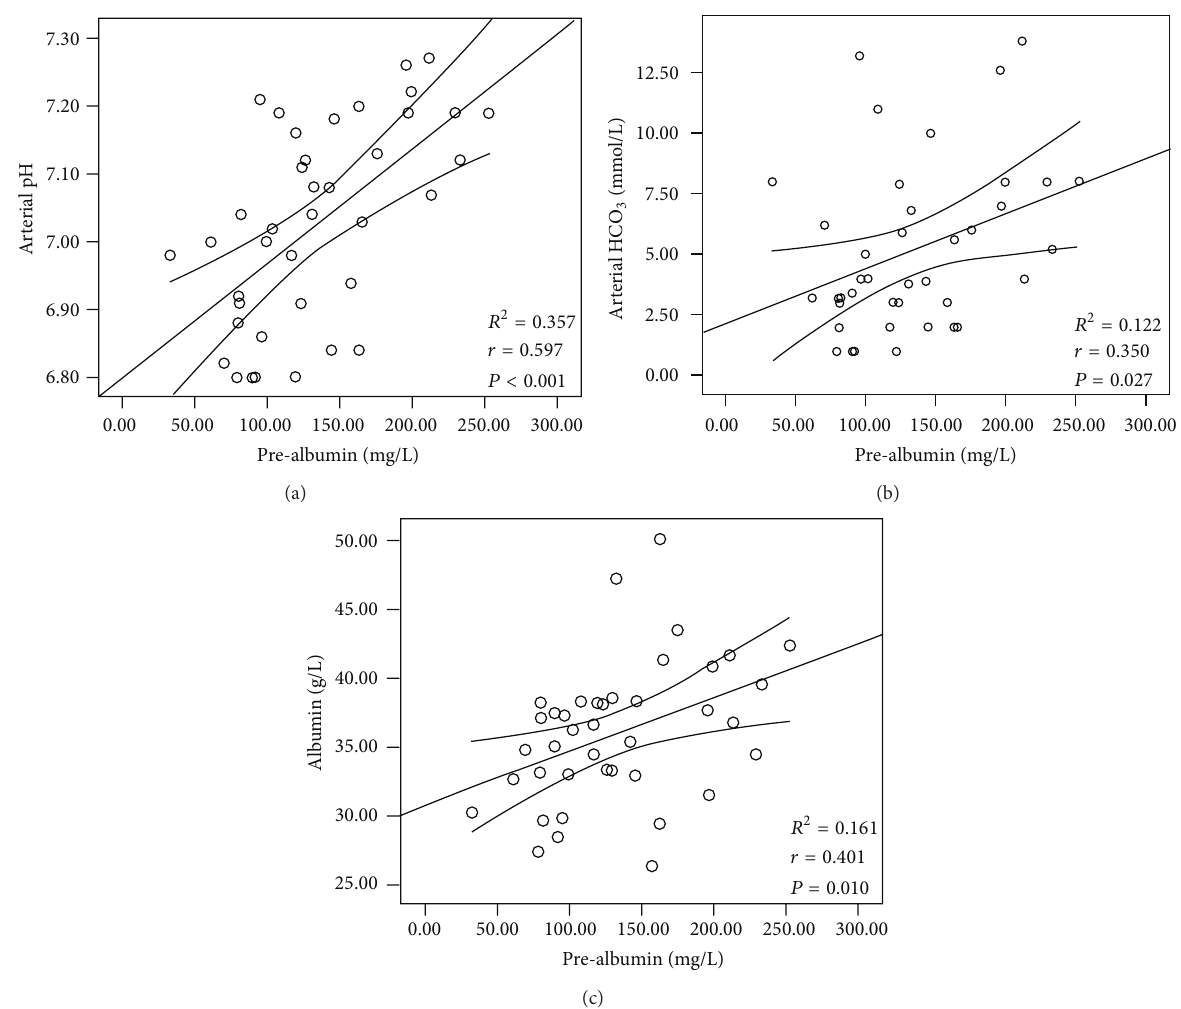
Figure 1: Serum prealbumin levels were positively correlated with the levels of albumin ((a): 𝑟 = 0.401 , 𝑃 = 0.010 ), HCO 3 ((b): 𝑟 = 0.350 , 𝑃 = 0.027 ), and arterial pH ((c): 𝑟 = 0.597 , 𝑃 < 0.001 ) in patients with